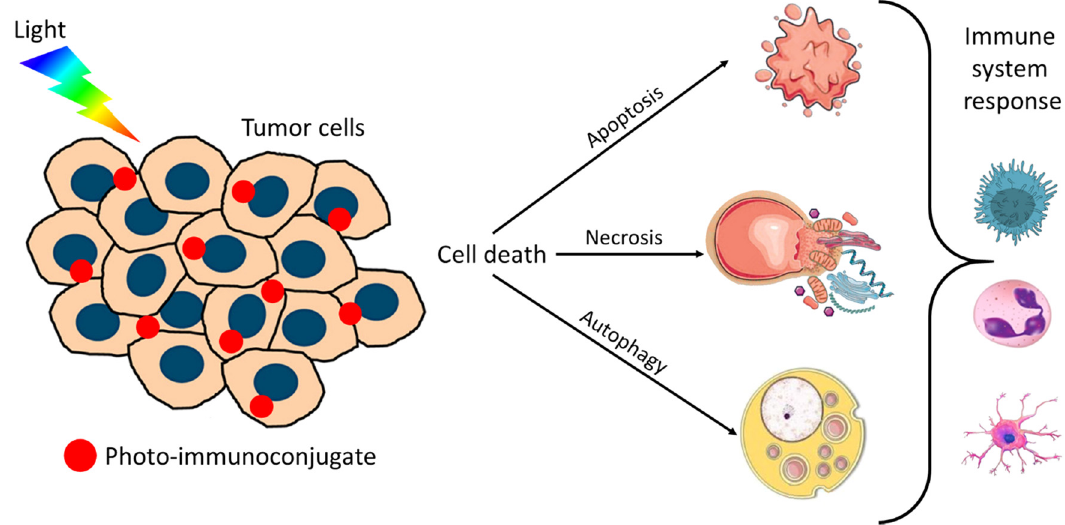
Figure 5: E ff ect of PDT on tumor cells. After irradiation, cells undergo one of the three main pathways of cell death; then, the released molecules activate the immune